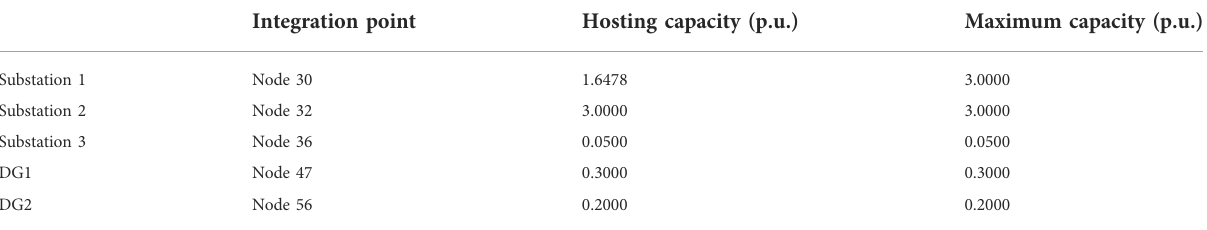
TABLE 1 Multi-objective optimization of joint DG-substation siting and sizing. Integration point Hosting capacity (p.u.) Maximum capacity